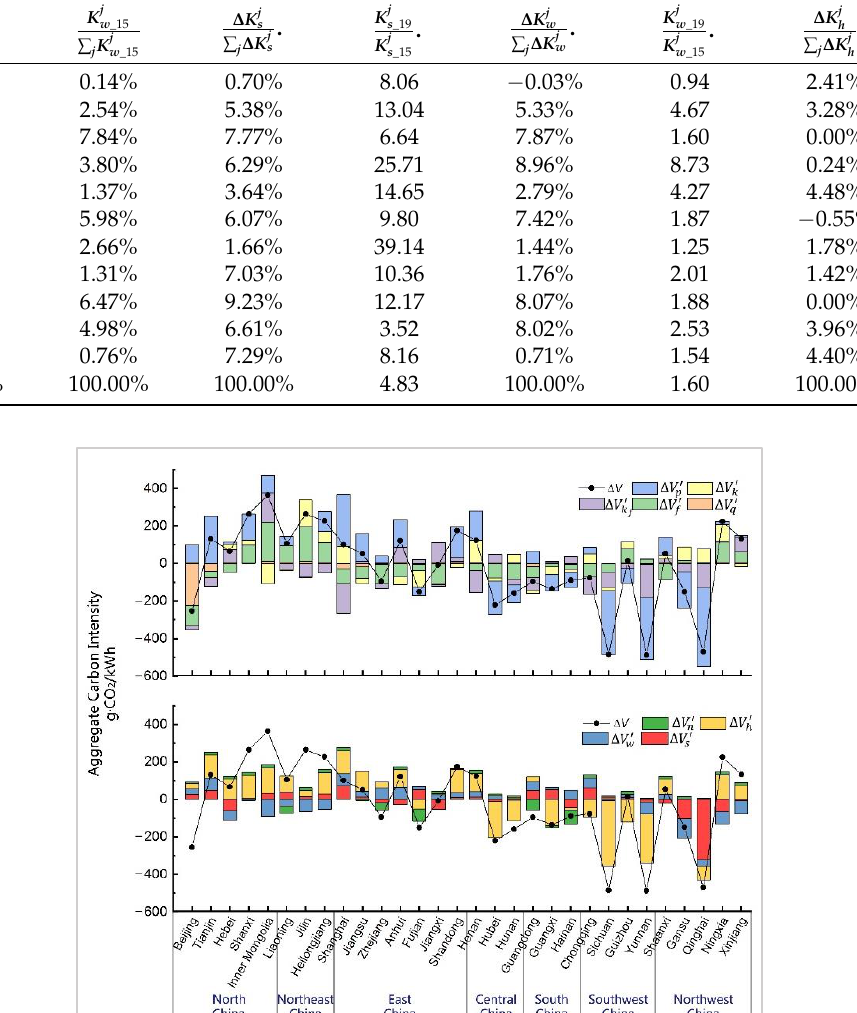
Table 3. Ratio and rate of non-fossil installed capacity growth in selected provinces.